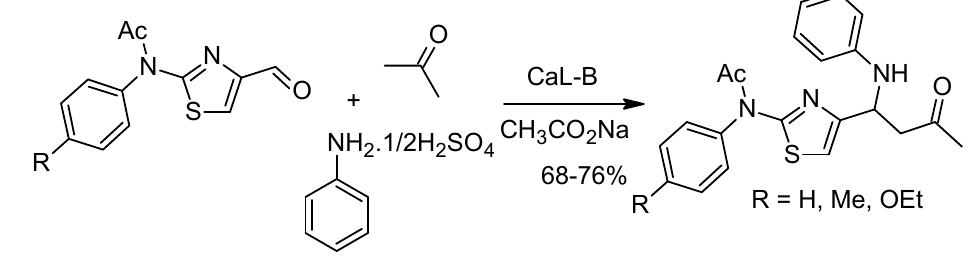
Scheme 15. Synthesis of 2-phenylthiazole Mannich bases.